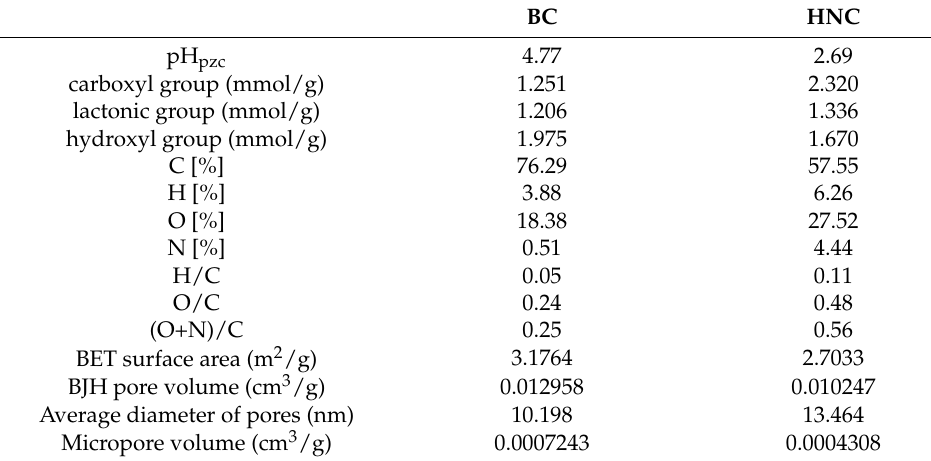
Figure 1. Morphological structure of BC ( a – d ) and HNC ( e – h ). Table 1. Physiochemical properties of BC and